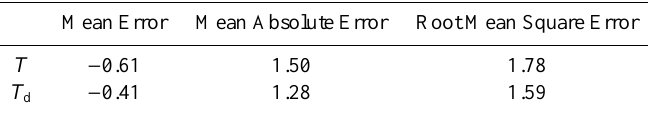
Table 1. Statistics (Mean Error, Mean Absolute Error and Root Mean Square Error) of Temperature ( T ) and Dew-Point Temperature ( T d ) at LGTS on 12 Feb 2010. Negative values of Mean Error indicate underestimation by WRF.